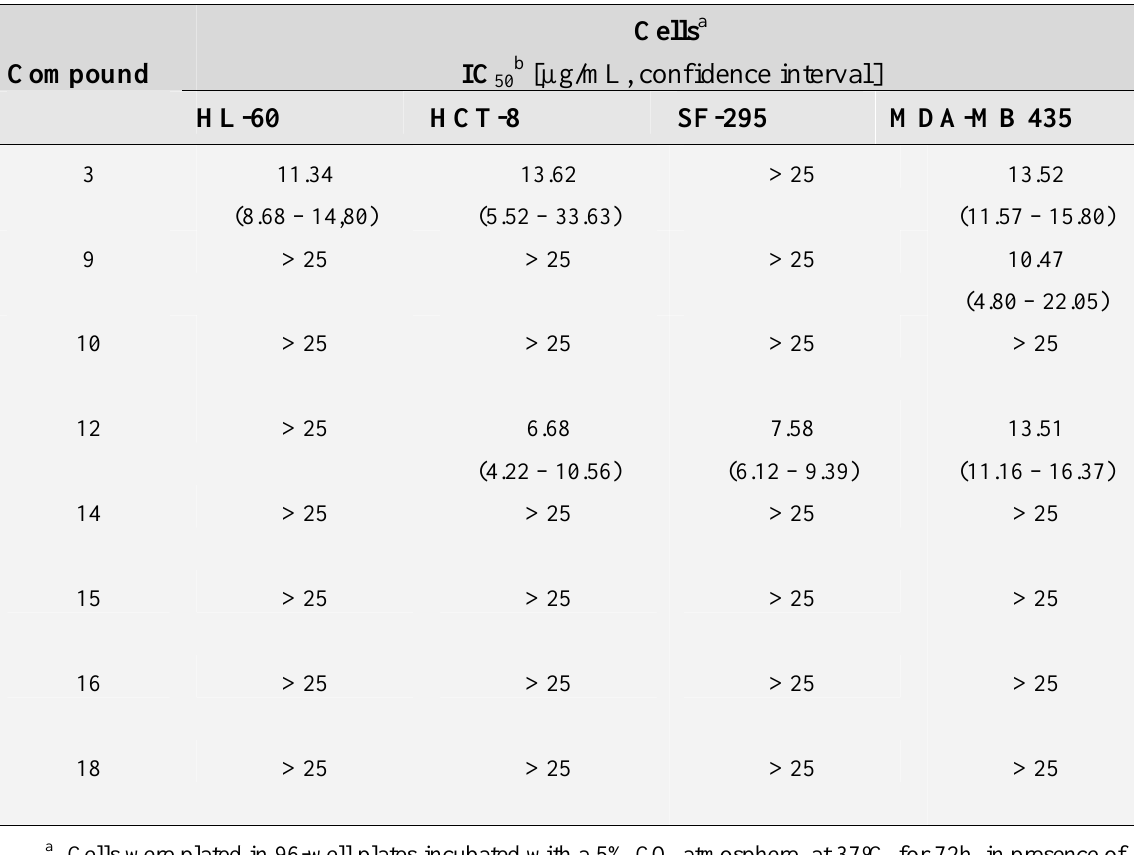
Table 2 . Cytotoxicity of compounds 3, 9, 10, 12, 14, 15 , 16 and 18 , based on inhibition of tumor cell